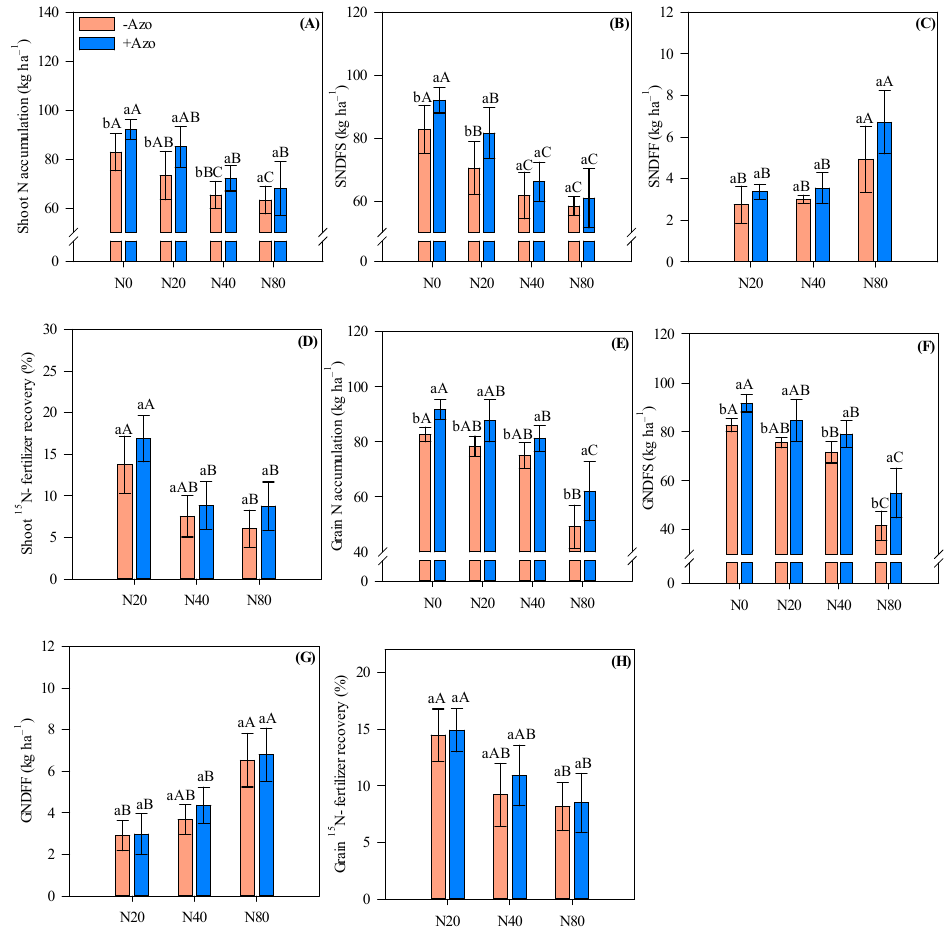
Figure 4. Cowpea N accumulation ( A ), N derived from soil and other sources (SNDFS) ( B ), N derived from fertilizer (SNDFF) ( C ) and 15 N fertilizer recovery in shoots ( D ), N accumulation ( E ), N derived from soil and other sources (GNDFS) ( F ), N derived from fertilizer (GNDFF) ( G ) and 15 N fertilizer recovery ( H ) in grain affected by inoculations and N fertilizer rates. Different letters indicate significant differences between treatments according to Tukey’s test ( p ≤ 0.05). Interaction between inoculations and N levels: Lowercase letters indicate significant differences between inoculations, and uppercase letters indicate significant differences between N levels according to Tukey’s test ( p ≤ 0.05). Error bars indicate standard deviations ( n = 4). −Azo and +Azo refer to the single inoculation with Bradyrhizobium sp. and co-inoculation with Bradyrhizobium sp. + A. brasilense, respectively; N0, N20, N40 and N80 refer to absence, 20, 40 and 80 kg N ha −1 applied.